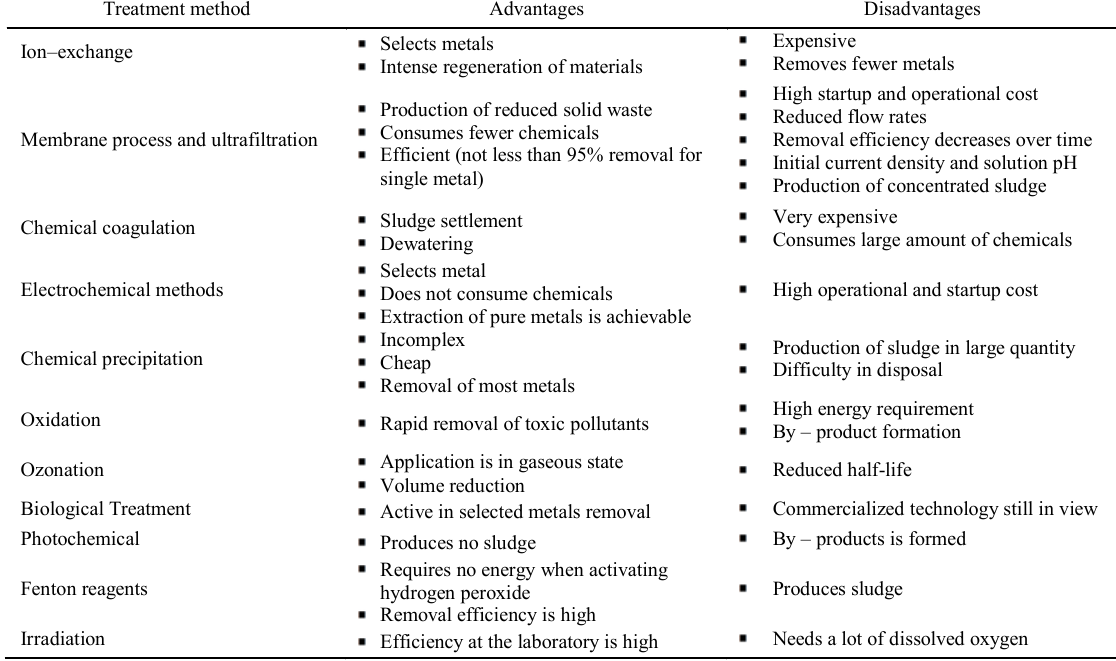
Table 2: Methods adopted for heavy metal